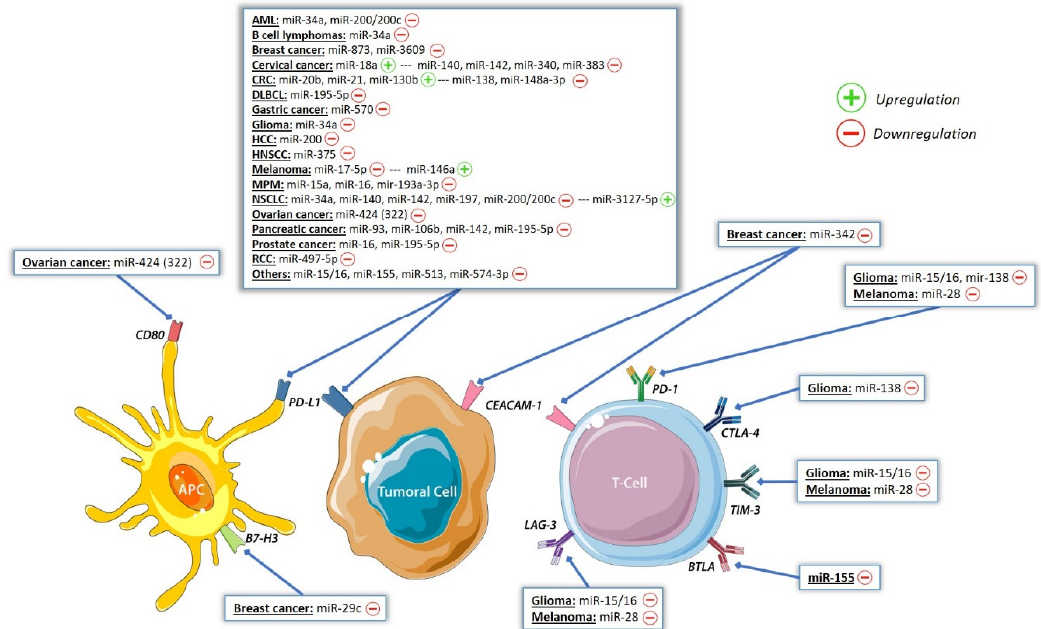
Figure 3. Roles of microRNAs on immune checkpoints. AML = acute myeloid leukemia, CRC = colorectal cancer, DLBCL= diffuse large B-cell lymphoma, HCC = hepatocellular carcinoma, HNSCC = head and neck squamous cell carcinoma, MPM = malignant pleural mesothelioma, NSCLC = non-small cell lung cancer, RCC = renal cell carcinoma, BTLA = B and T lymphocyte attenuator, CEACAM-1 = carcinoembryonic antigen-related cell adhesion molecule 1, LAG-3 = lymphocyte activation gene 3 protein and TIM-3 = T cell immunoglobulin mucin receptor 3.